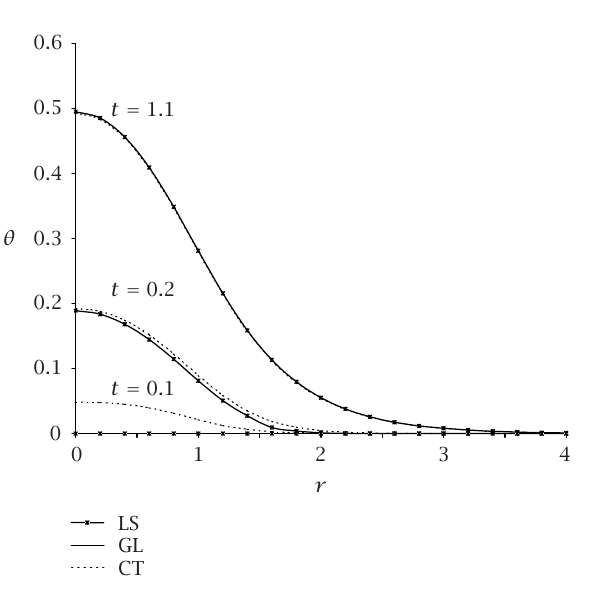
Figure 5.1. Temperature distribution in the middle plane.